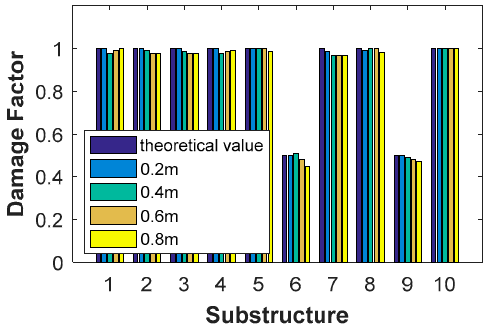
ff erent immersion